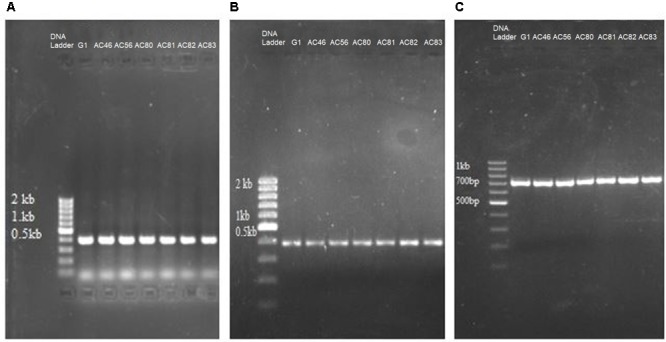
PCR detection of genes related to CS pathogenicity in seven Streptomyces isolates. Shown are the agarose electrophoresis gels of PCR reactions amplifying (A)
txtAB; (B)
nec1; (C)
tomA. The name of each isolate (G1, AC46, AC56, AC80, AC81, AC82, AC83) is shown above the respective lanes of the gels.